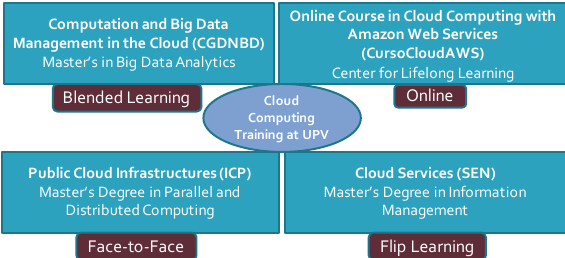
Figure 3. Cloud computing training at the Universitat Politècnica de València, in